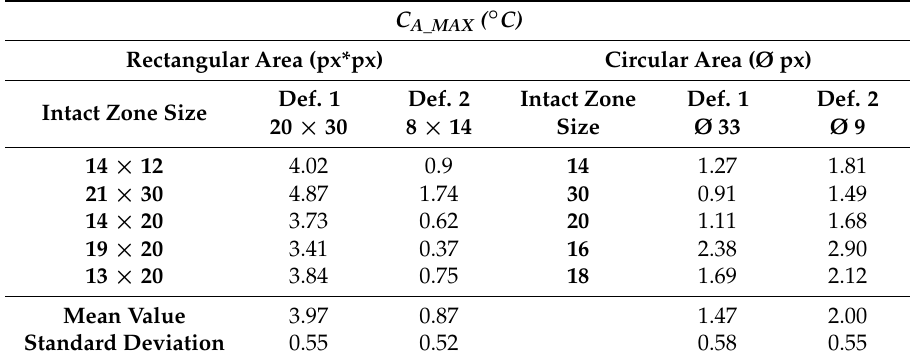
Table 7. Maximum absolute contrast value for rectangular and circular computation shape zone.